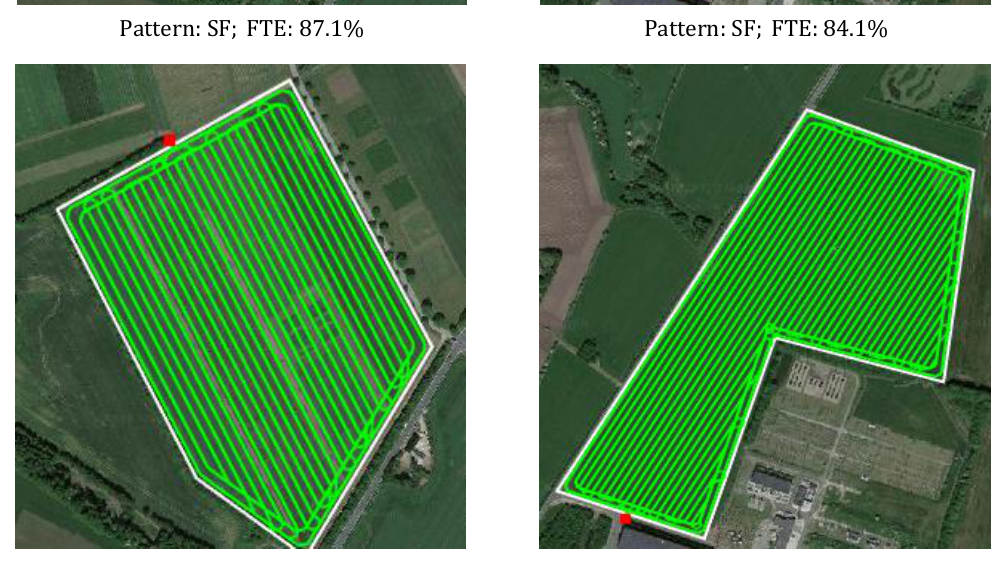
Figure 13. Demonstration of the effect of the field-work pattern on FTE. Other parameters are the same for all cases (operating width: 9 m; turning radius: 6 m; number of headlands: 2).